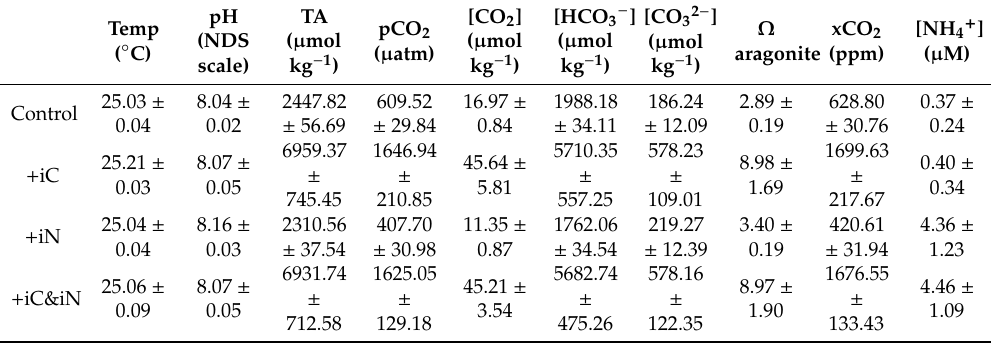
Table 1. Mean carbonate chemistry parameters and NH 4 + concentrations for the four treatments representing two HCO 3 − (control vs. 6000 µ mol kg − 1 ) concentrations and two NH 4 + concentrations (control vs. 4 µ M); n =